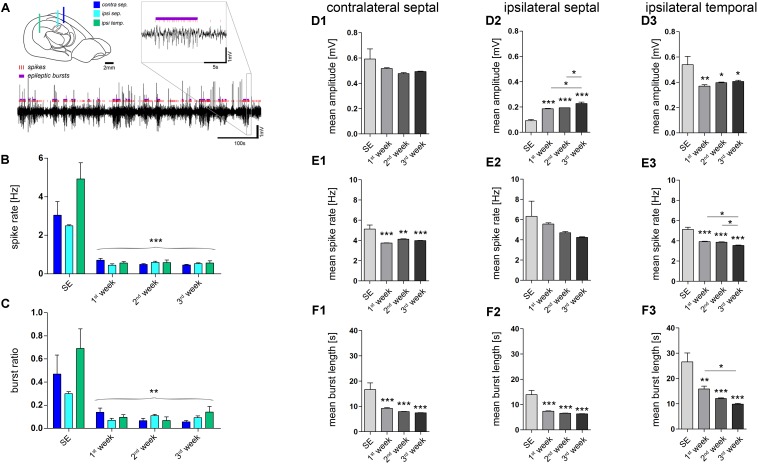
Quantitative analysis of paroxysmal burst features. (A) Schematic illustrating the recording sites and a representative LFP trace in which individual population spikes (red lines) and paroxysmal episodes (violet bars) were detected by an automated algorithm. Brain sketch modified from Witter and Amaral (2004). (B) Quantitative analysis of the overall spike rate per recording and (C) the relative time spent in a paroxysmal state (burst ratio). Color-code corresponds to legend in A. (D–F) Quantitative analysis of burst features for each hippocampal location: (D1–D3) Mean amplitude during burst; (E1–E3) mean spike rate; (F1–F3) mean burst length (1, contralateral septal; 2, ipsilateral septal; and 3, ipsilateral temporal). Number of mice: nSE = 3, n1w = 4, n2w = 3, n3w = 5. One-way ANOVA, Newman–Keuls’s post-test. ∗P < 0.05, ∗∗P < 0.01, ∗∗∗P < 0.001. Significance signs above bars indicate significant difference to SE values. All values are represented as the mean+SEM.